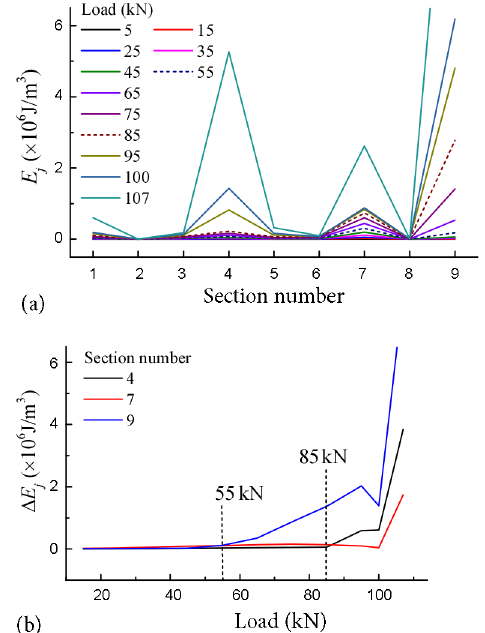
Figure 5. The GSED-based stressing state mode of arch D: a – the S -load curve; b – the ∆ E j -load